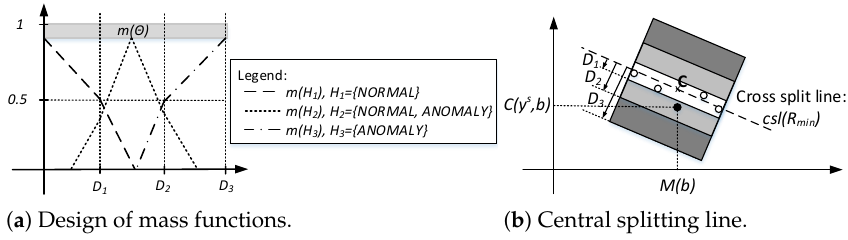
Figure 11. Example design of mass functions and central